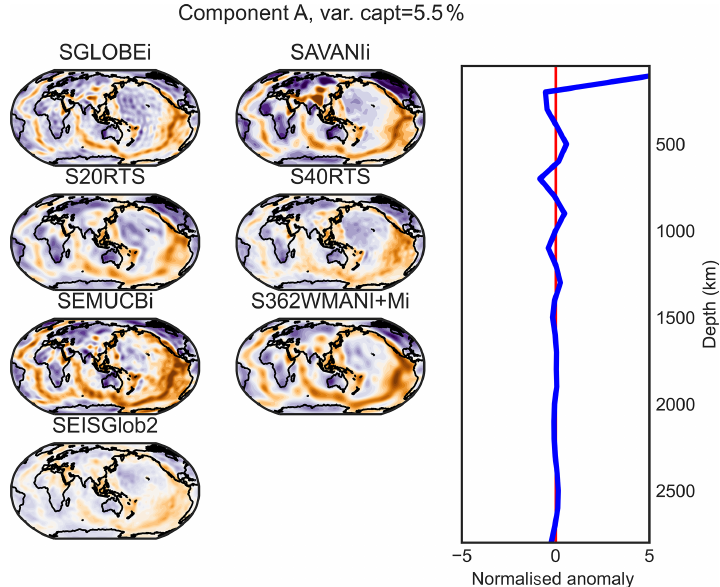
Figure D1. PC A (maximum at 50km of depth) of the combined analysis of the isotropic parts of the models. On the right are the principal components or vertical profiles, and on the left are the associated horizontal structures.